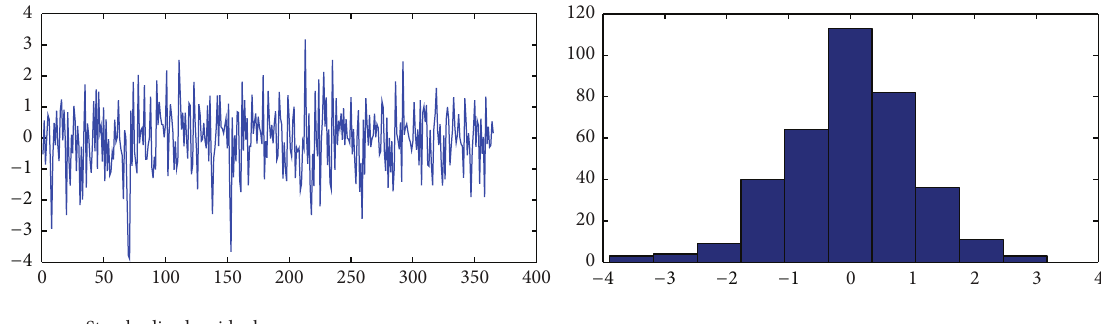
Figure 7: Plot and histogram of standardized